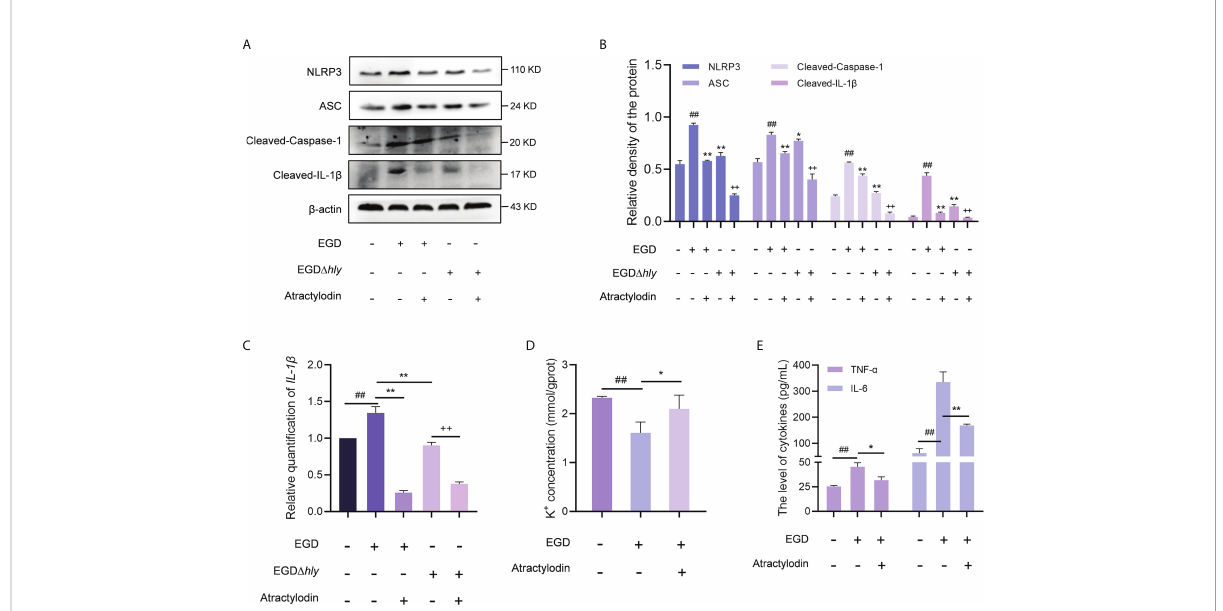
FIGURE 7 Atractylodin effectively suppressed L. monocytogenes -activated NLRP3 in fl ammasome. (A) J774A.1 cells were infected with EGD or EGD D hly , following the treatment with atractylodin (4 m g/mL) for 6 h and then immunoblotting with speci fi c antibodies. (B) The levels of NLRP3, ASC, Cleaved-Caspase-1 and Cleaved-IL-1 b relative to b -actin determined using densitometry were shown. (C) The relative expression of mRNA of IL-1 b in J774A.1 cells in the presence or absence of atractylodin was determined by RT-qPCR. (D) The intracellular content of K + in J774A.1 cells with the presence of DMSO or 4 m g/mL atractylodin was evaluated using a K + detection assay kit. (E) The production of IL-6 and TNF- a in the peritoneal macrophage treated with or without atractylodin were measured using ELISA. Data are represented as the mean ± SEM. ## P < 0.01 vs the vehicle control group; * P < 0.05 and ** P < 0.01 vs the EGD-infection group; ++ P < 0.01 vs the EGD D hly -infection